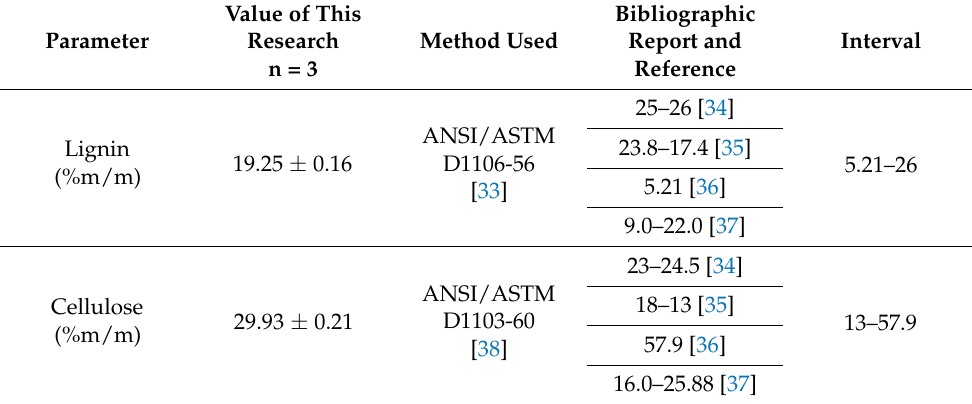
Table 1. Lignin and cellulose content in